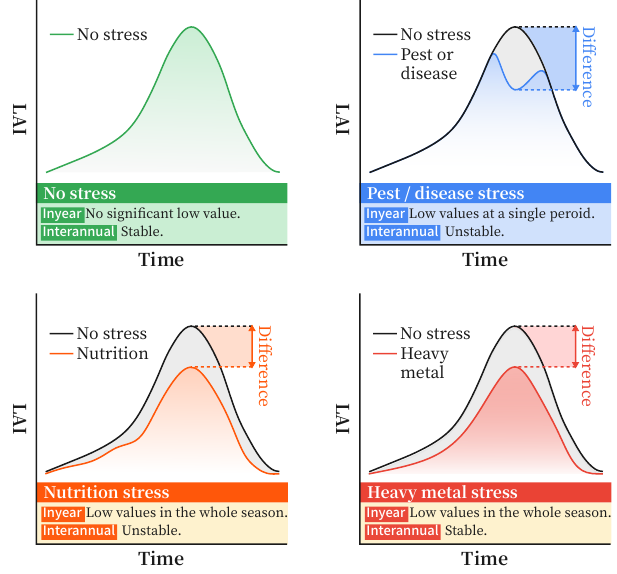
Figure 4. Conceptual rice series under different stress